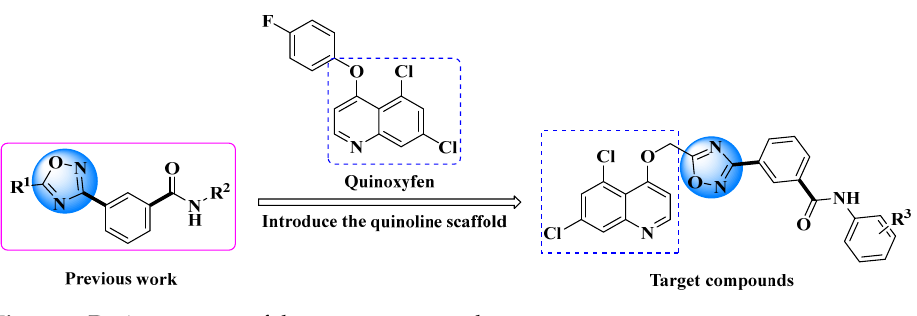
Figure 2. Design strategy of the target compounds.